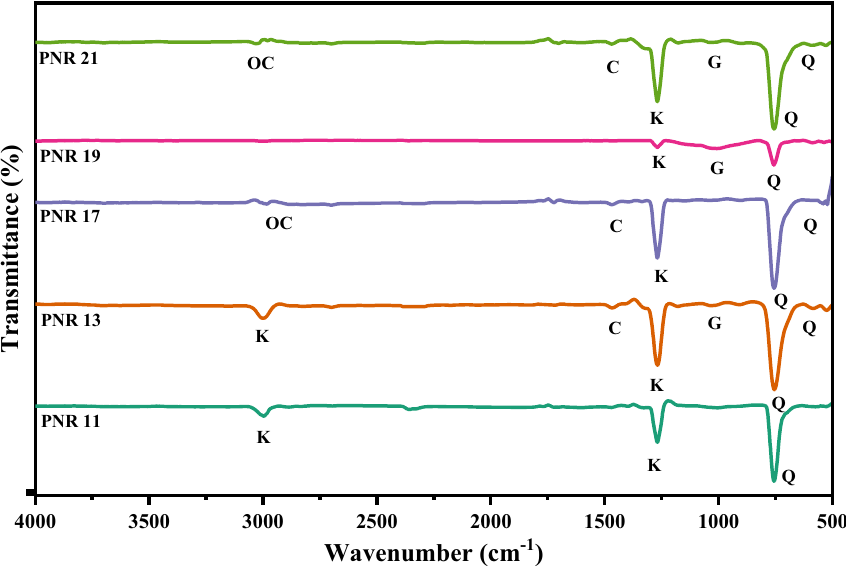
Figure 3. FT-IR spectrum of river sand samples PNR11–PNR21.